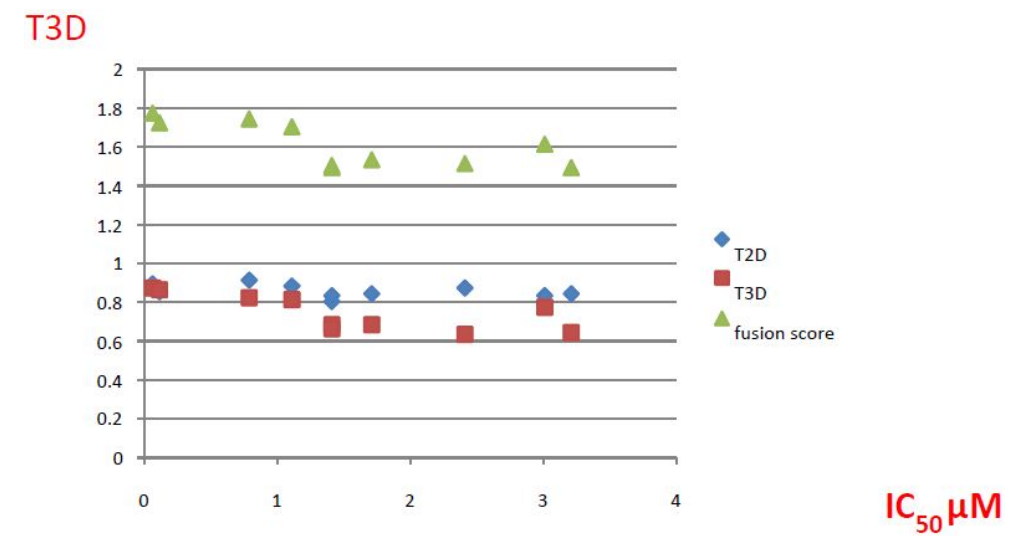
Figure 8. T2D/T3D and fusion score analysis of the 10 second round